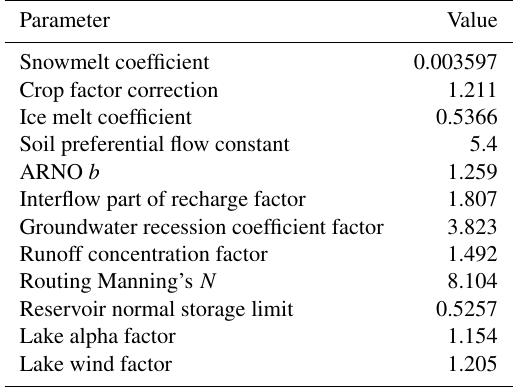
Table 2. Calibration parameters values for convergence of